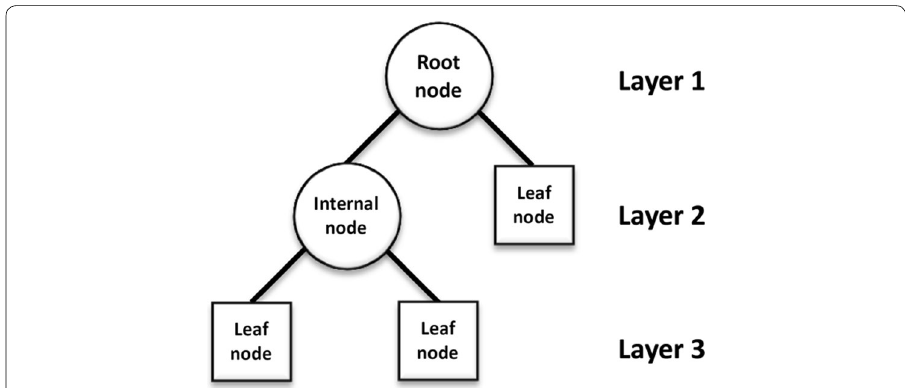
Fig. 3 An example of decision tree